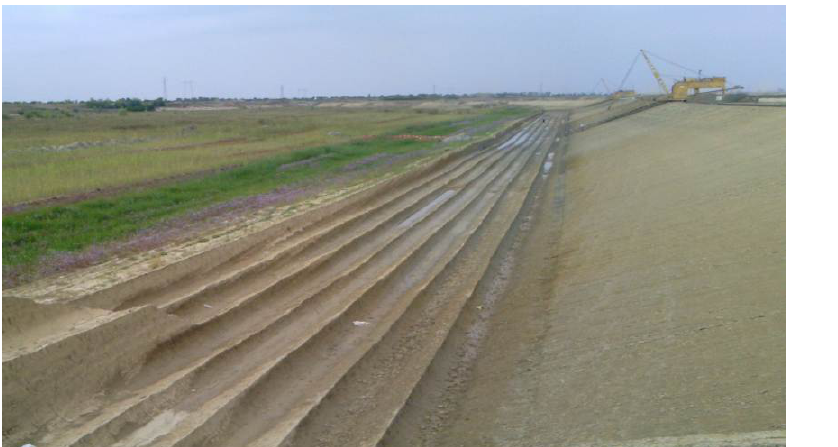
Рис . 15 – Изображение настоящей поверхности местности Слика 15 – Изглед стварне површи терена